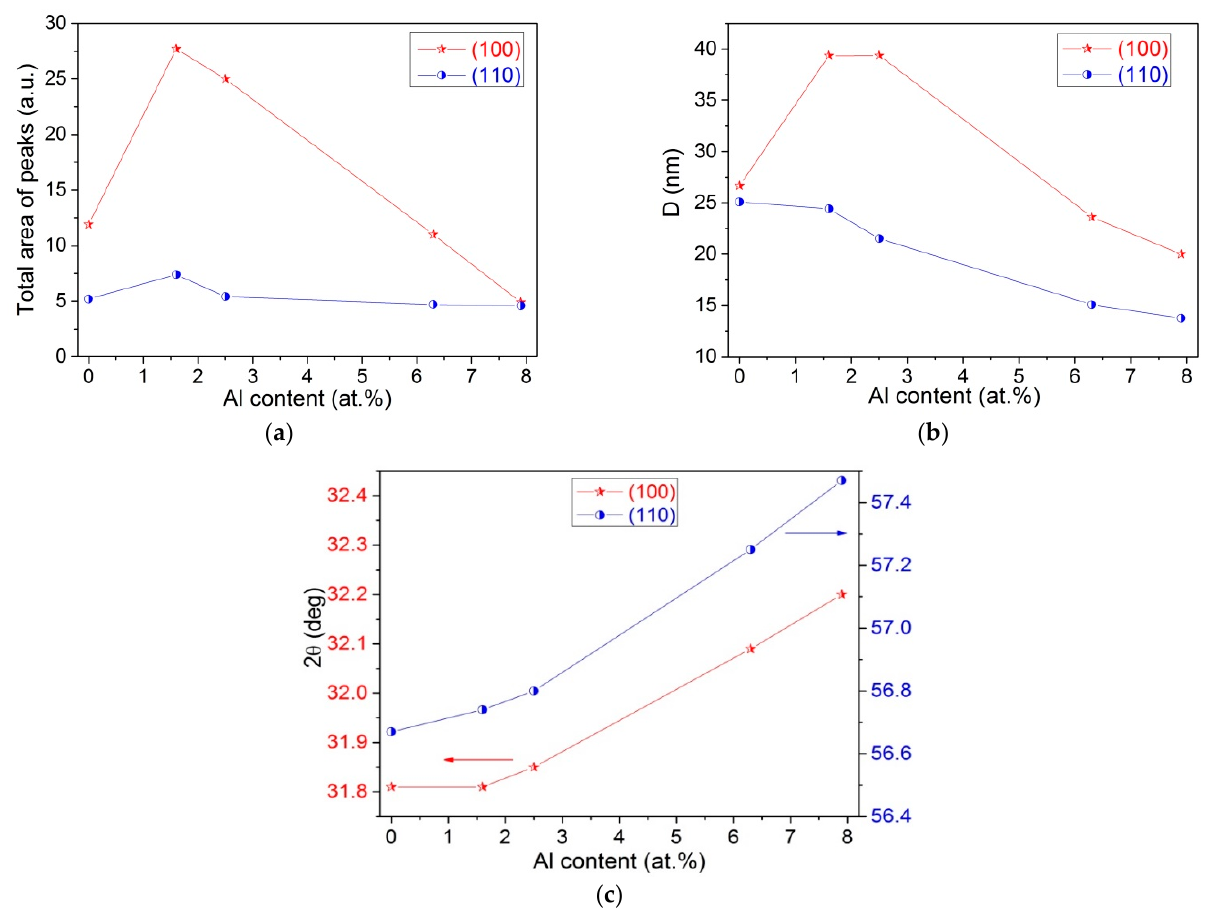
Figure 4. ( a ) The total peak area; ( b ) the grain size and ( c ) 2 θ position of the (100) and (110) ZnO peaks, as a function of Al concentration (at.%).